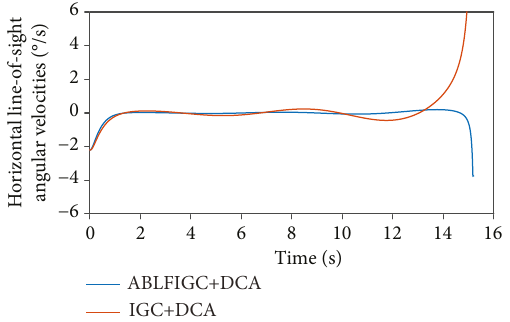
Figure 3: Curves of angular velocities of horizontal line of sight of the interceptor missile in Scenario 1: ABLFIGC+DCA refers to a combination of the proposed asymmetric barrier Lyapunov function-based IGC algorithm and the dynamic control allocation algorithm; IGC+DCA refers to a combination of the IGC algorithm subject to the traditional dynamic surface sliding-mode control law and the dynamic control allocation algorithm.